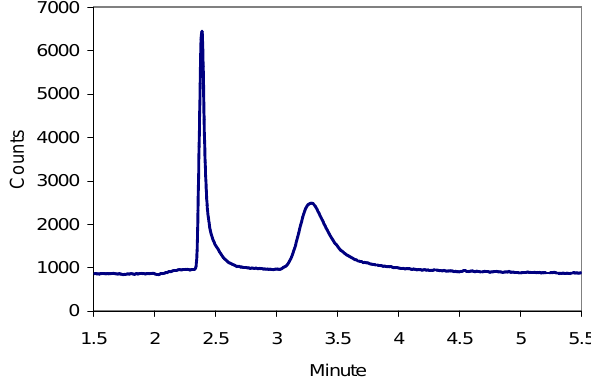
Fig. 1. Typical RGA chromatogram. The sample was injected at the 2minute mark. The first eluted peak corresponds to H 2 , whereas the second one corresponds to CO.